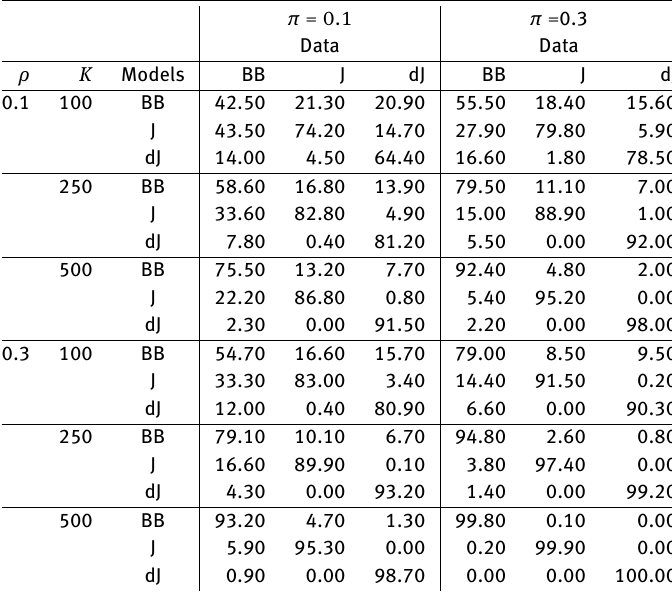
Table 2: Small cluster simulations: The proportion of times that a model is selected by the AIC criterion as a function of the model used to simulate the data.